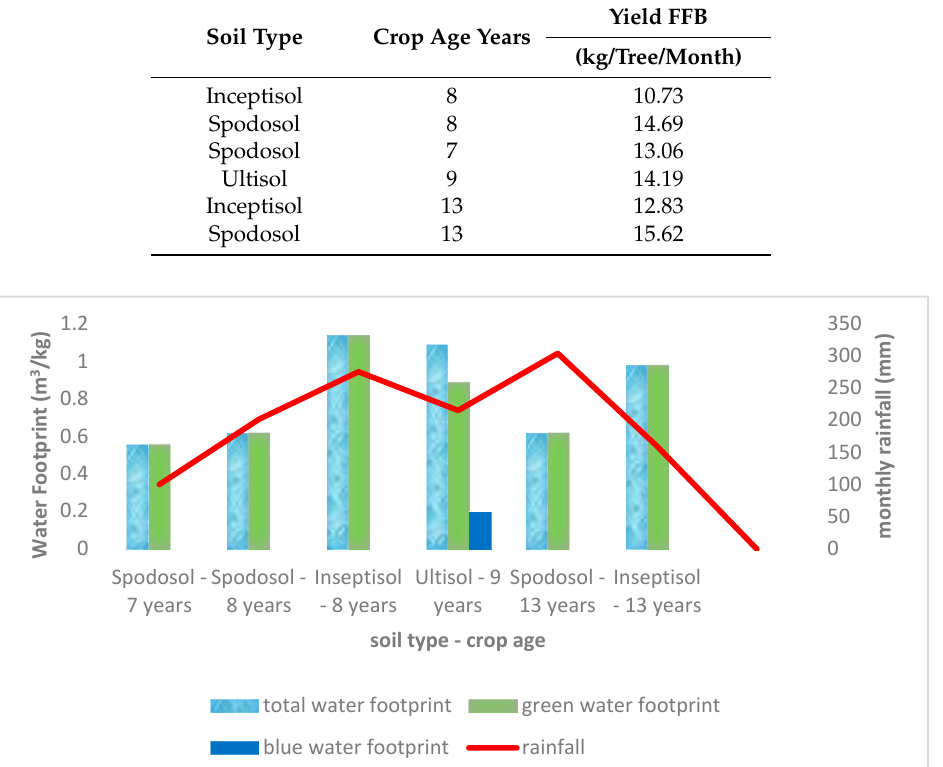
Table 4. Yield production of the fresh fruit bunch (FFB) (kg/tree/month) in the field study.